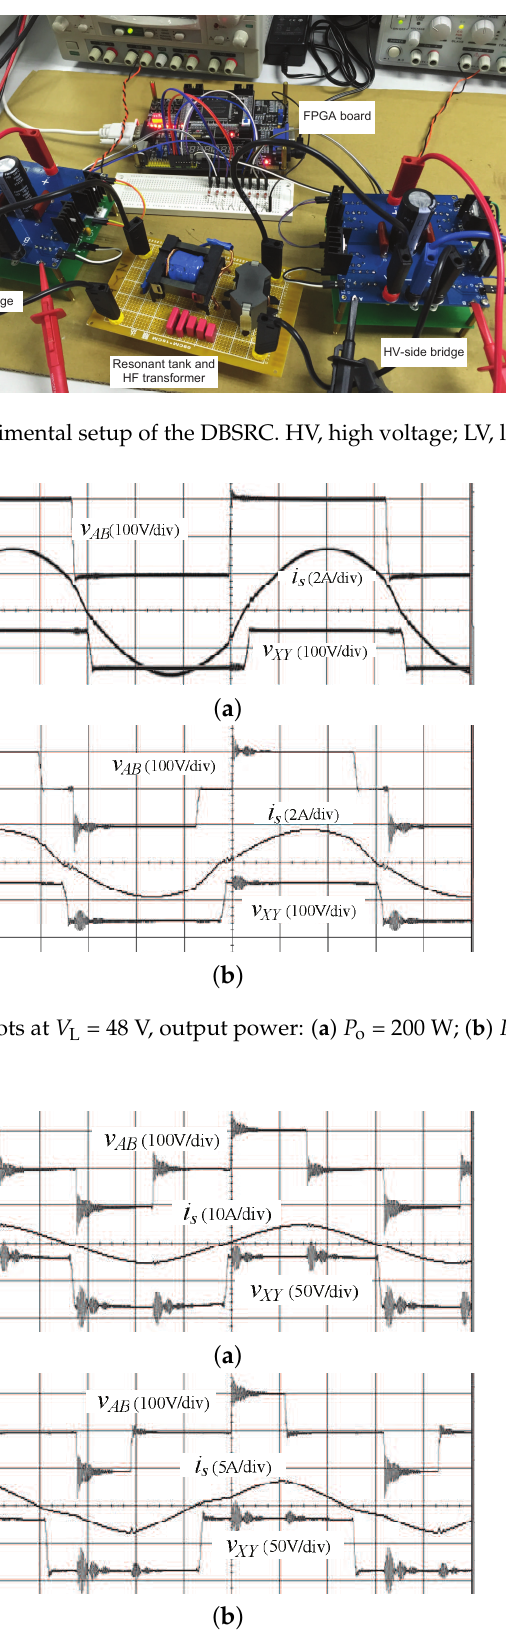
Figure 12. Experimental plots at V L = 28.8 V, output power: ( a ) P o = 200 W; ( b ) P o = 100 W. Time scale: 1.52 µ